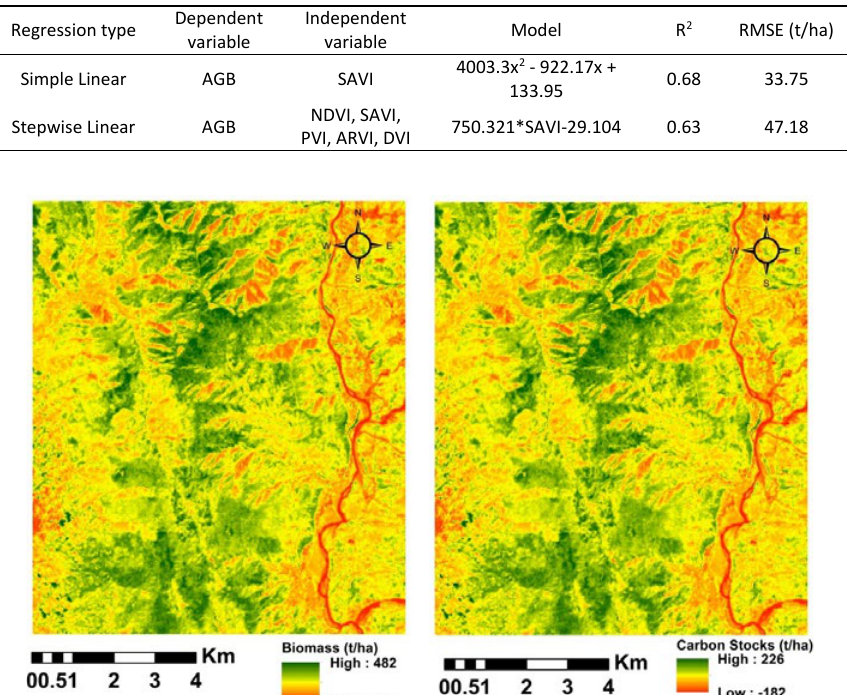
Fig. 7. Biomass and carbon stock estimation using landsat- Fig. 7: Biomass and carbon stock estimation using landsat- image